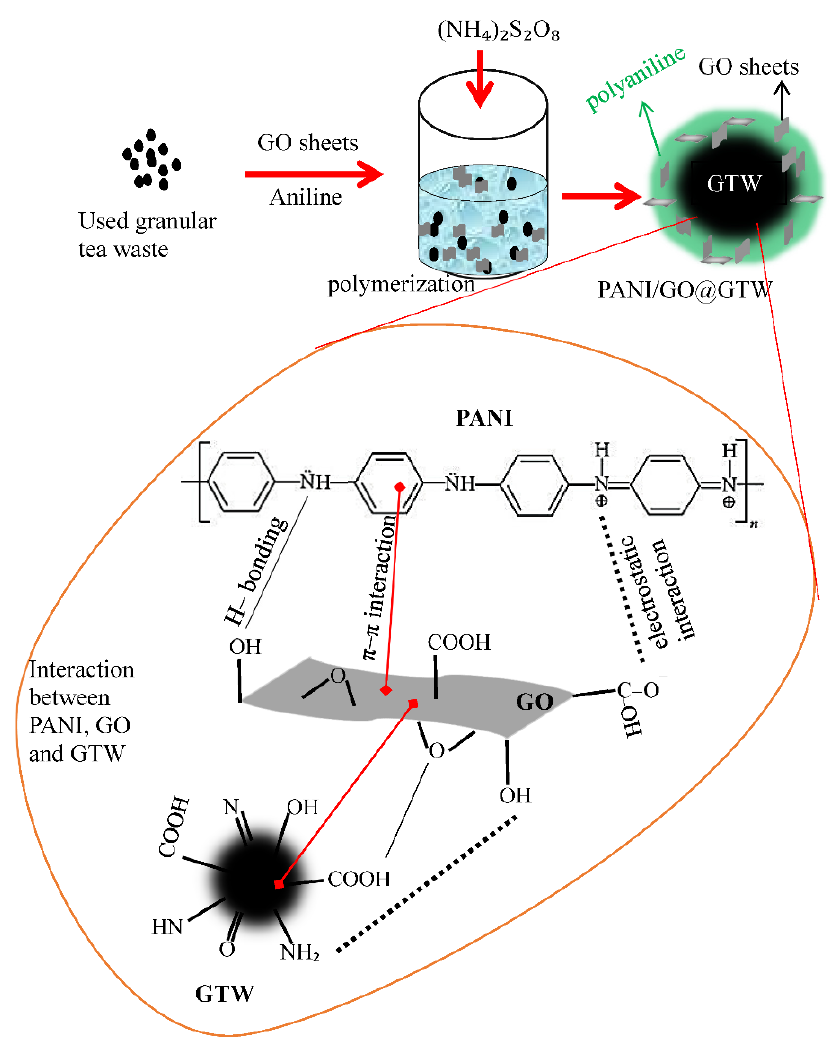
Figure 1. Schematic diagram for the synthesis of the PANI/GO@GTW